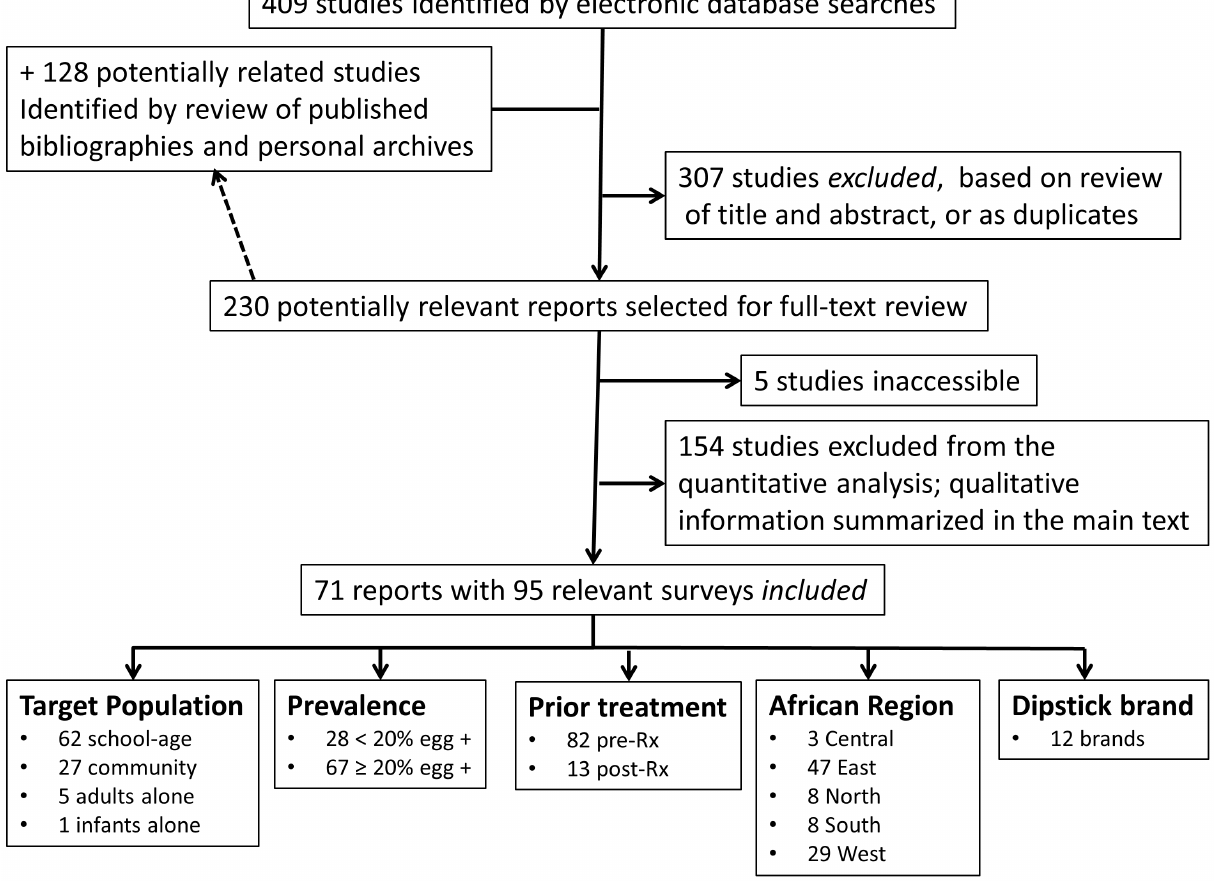
Figure 1. Flow chart of study search and selection strategy.